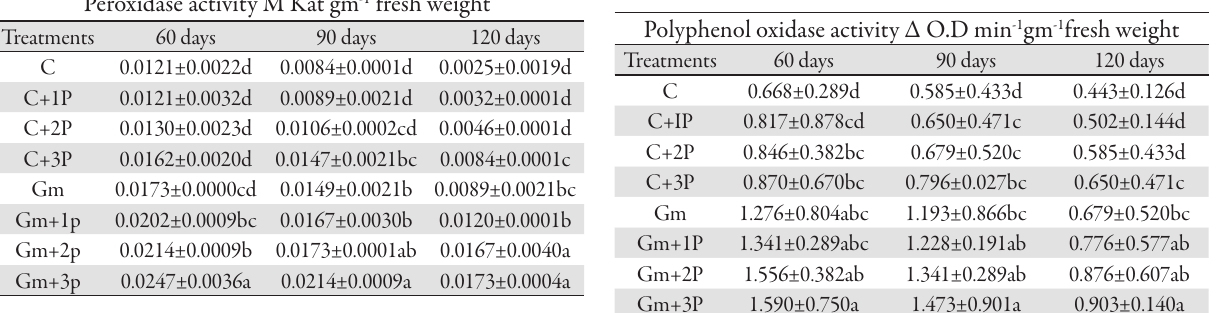
Tab. 3. Polyphenol oxidase activity in Solanum melongena L.